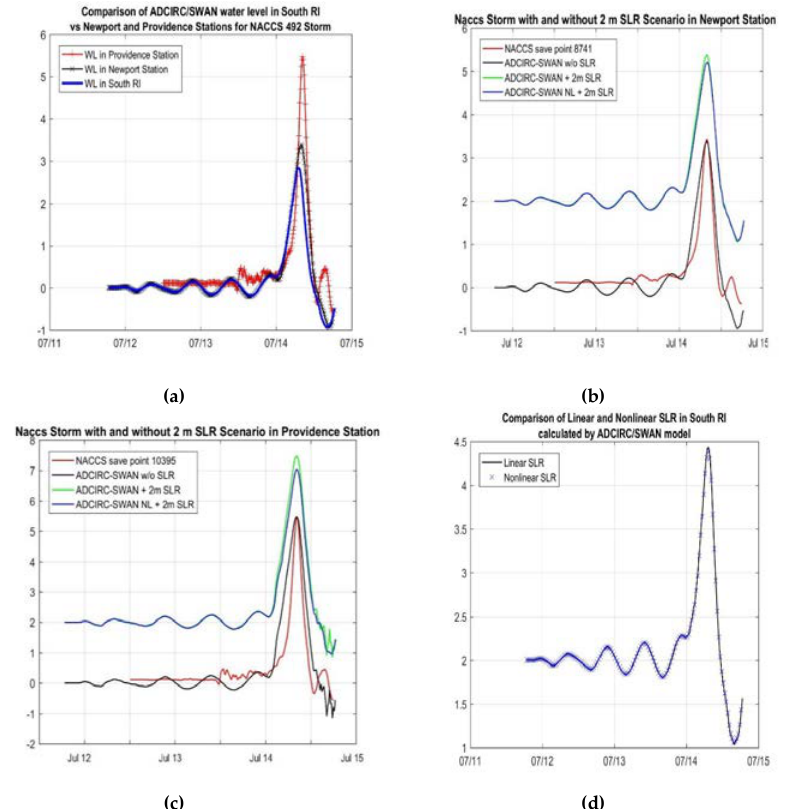
Figure 3. ( a ) Water level vs. time for NACCS storm #492 at Providence, Newport, and Charlestown, RI; ( b ) ADCIRC-SWAN-predicted water level vs. time for NACCS storm #492 at Newport without sea level rise (SLR), with 6.6 ft (2 m) of SLR simply added on, and with 2-m SLR added to the initial bathymetry and simulations run with the full model, ( c ) same as in ( b ) but at the Providence station; and ( d ) results of linear (superposition) and nonlinear simulation at Charlestown. Table 1. Maximum water level at Newport and Providence from NACCS storm #492 for the save point closest to these locations (NACCS save point #8741-Newport, #10395-Providence) based on the original simulations, as a result of the application of ADCIRC-SWAN high-resolution model (Torres et al., 2018) [15] without SLR, with 2-m SLR simply added, and with 2-m SLR added to the initial bathymetry and nonlinear simulations performed.